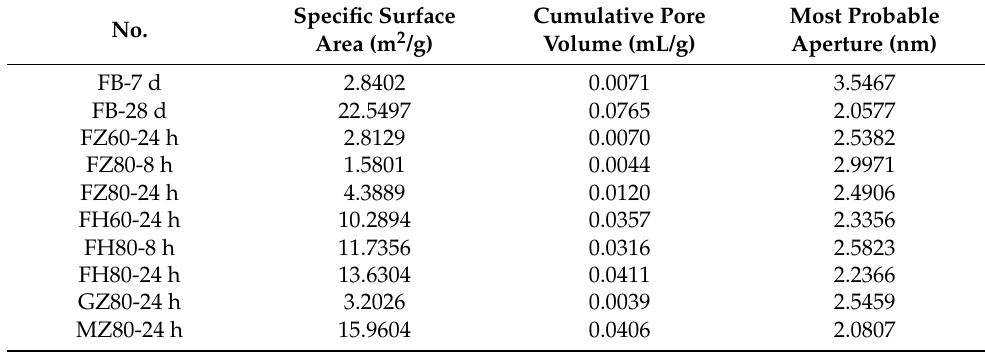
Table 4. Pore structure parameters of alkali-activated cement under different curing